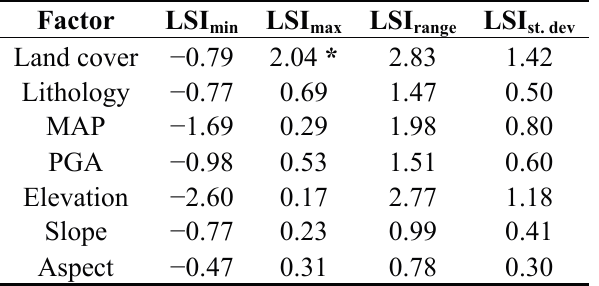
Table 2. Landslide susceptibility index (LSI) properties of the conditioning